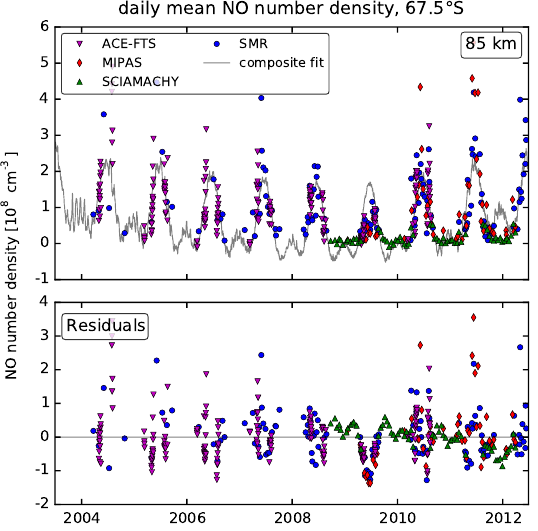
Figure 13. NO time series regression results at 67.5 ◦ S, 85km, as in Fig. 11.